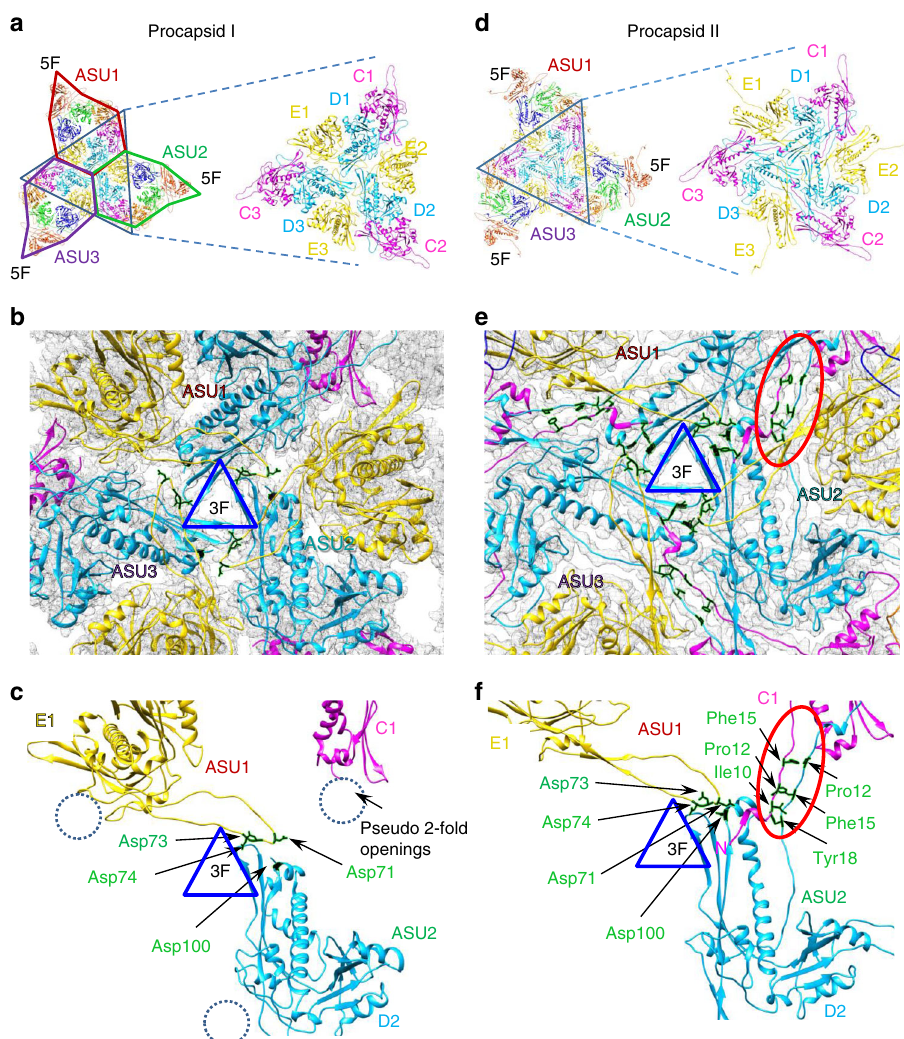
Fig. 3 Inter-capsomere interactions. a Schematic representation of subunit positions around the threefold axis in the procapsid I face. b Cryo-EM density of procapsid I with the gp13 MCP atomic model superimposed. c Points of interaction between subunits from different capsomeres are shown by arrows and the residues are labelled in green. d Schematic representation of subunits around the threefold axis in the procapsid II face. e gp13 MCP atomic models superimposed in the cryo-EM map of procapsid II. f Points of interaction between subunits of adjacent capsomeres. The red ovals in e and f show the region of antiparallel N-termini interaction. The residues involved in interactions are displayed in